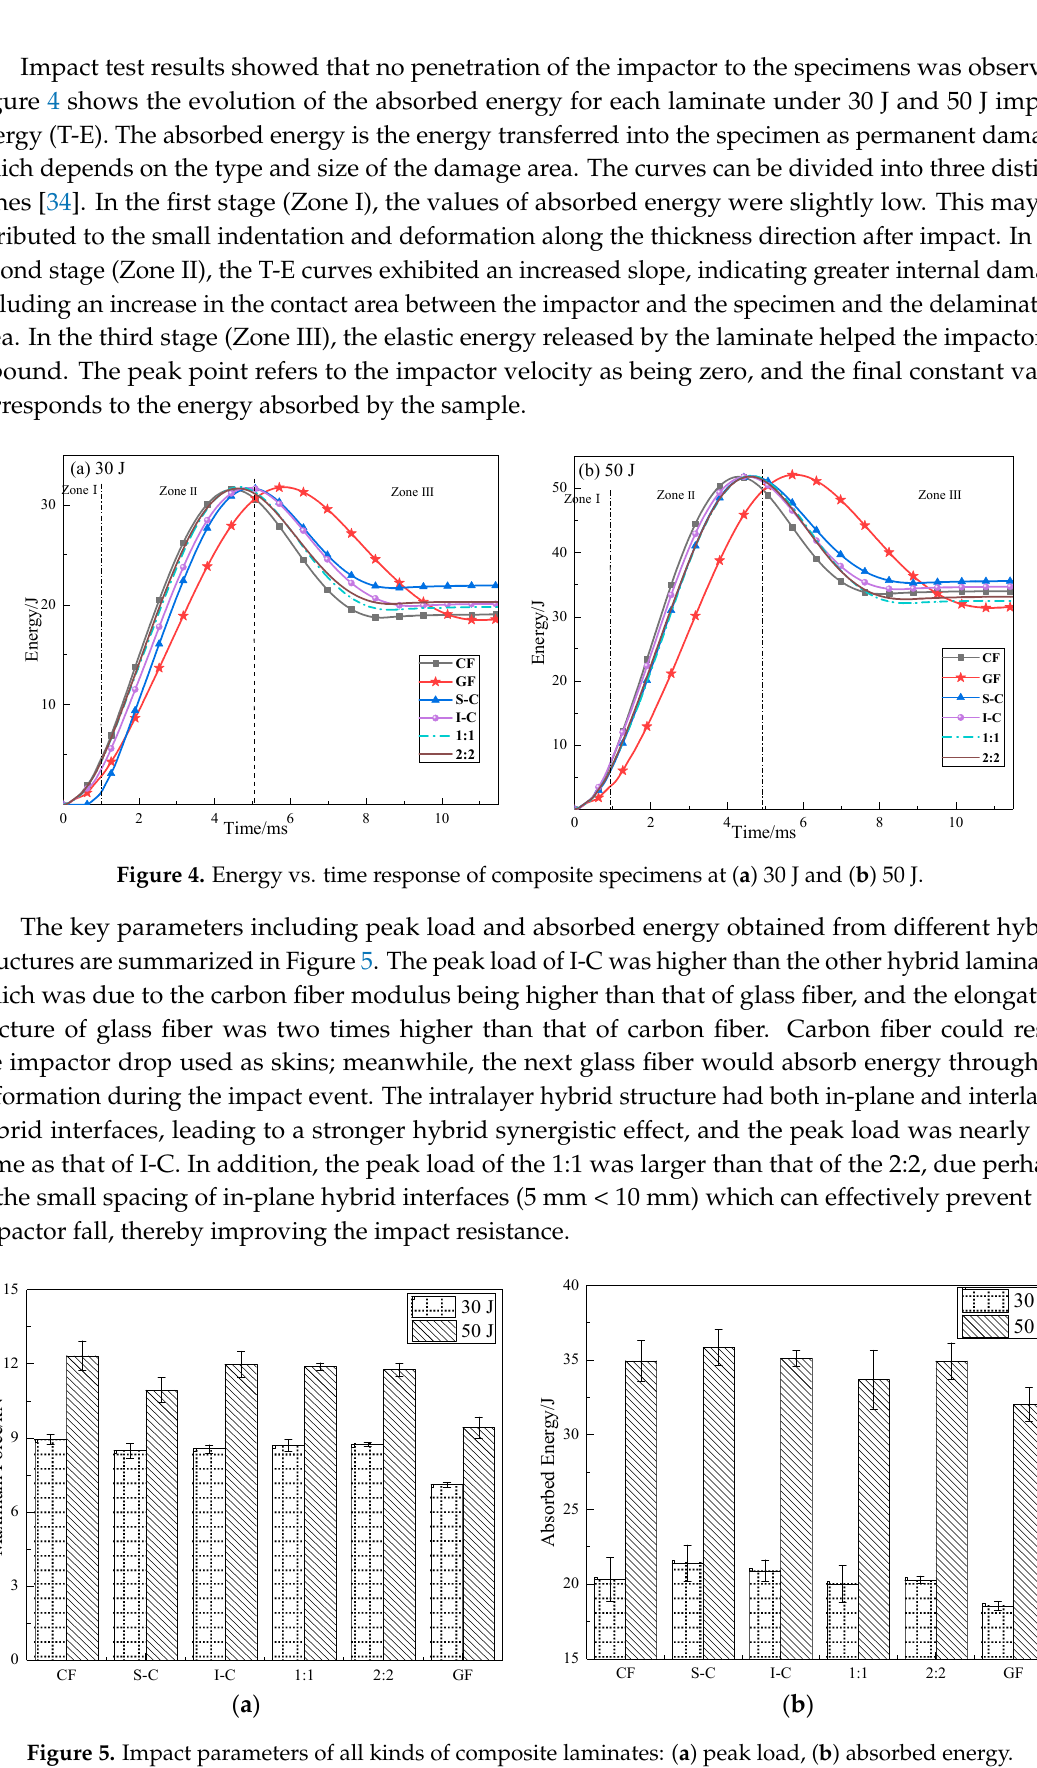
Figure 5. Impact parameters of all kinds of composite laminates: ( a ) peak load, ( b ) absorbed energy.